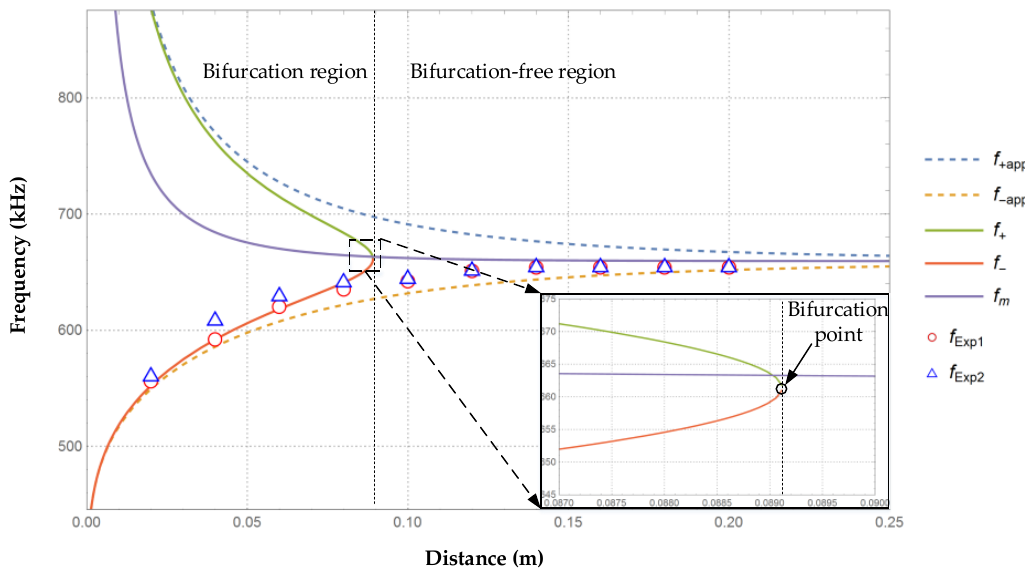
Figure 11. Calculated and measured zero phase angle (ZPA) frequencies of a parallel-resonant circuit versus